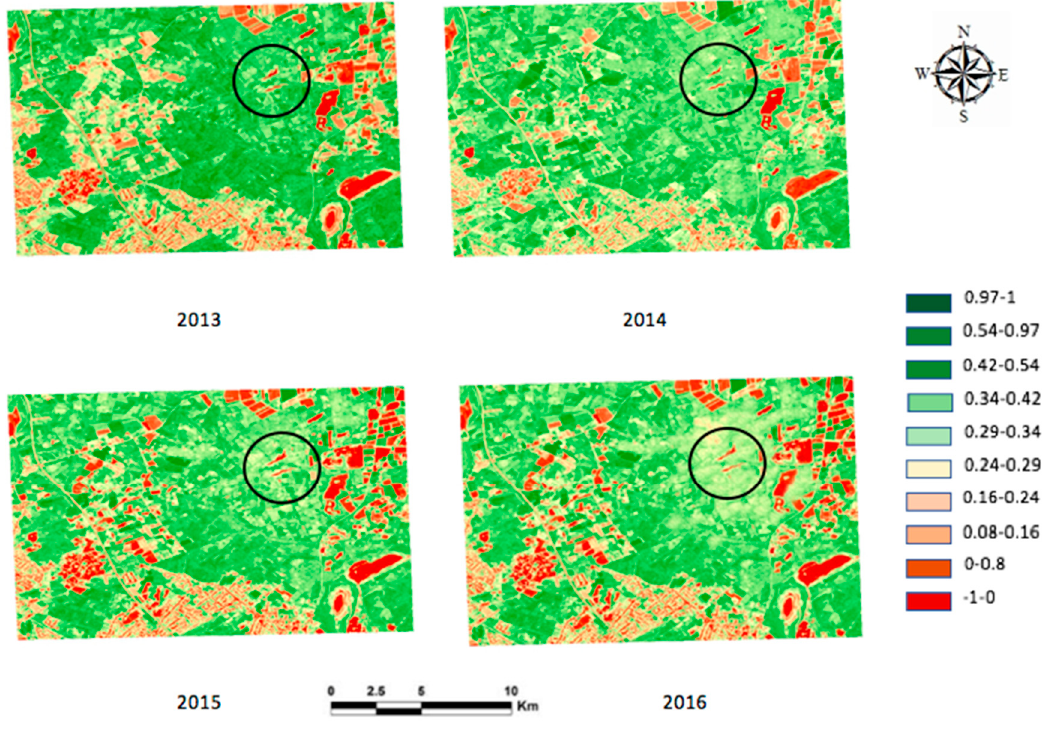
Figure 6. Cont. Figure 6.